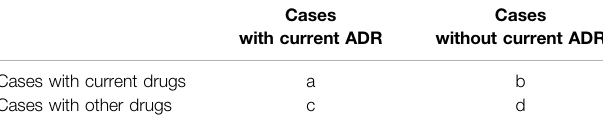
TABLE 1 | Contingency table for the calculation of reported odds ratio. Cases with current